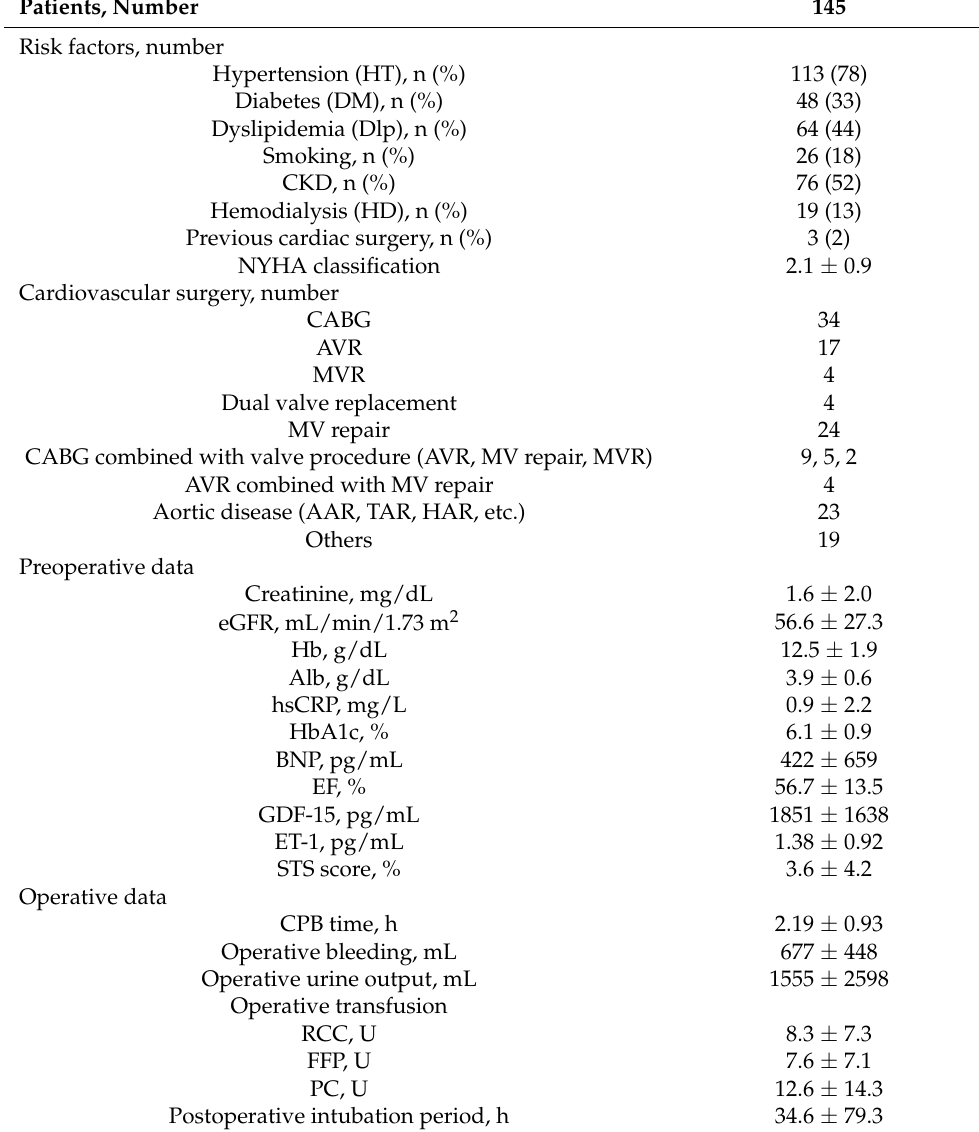
Table 1. Patient